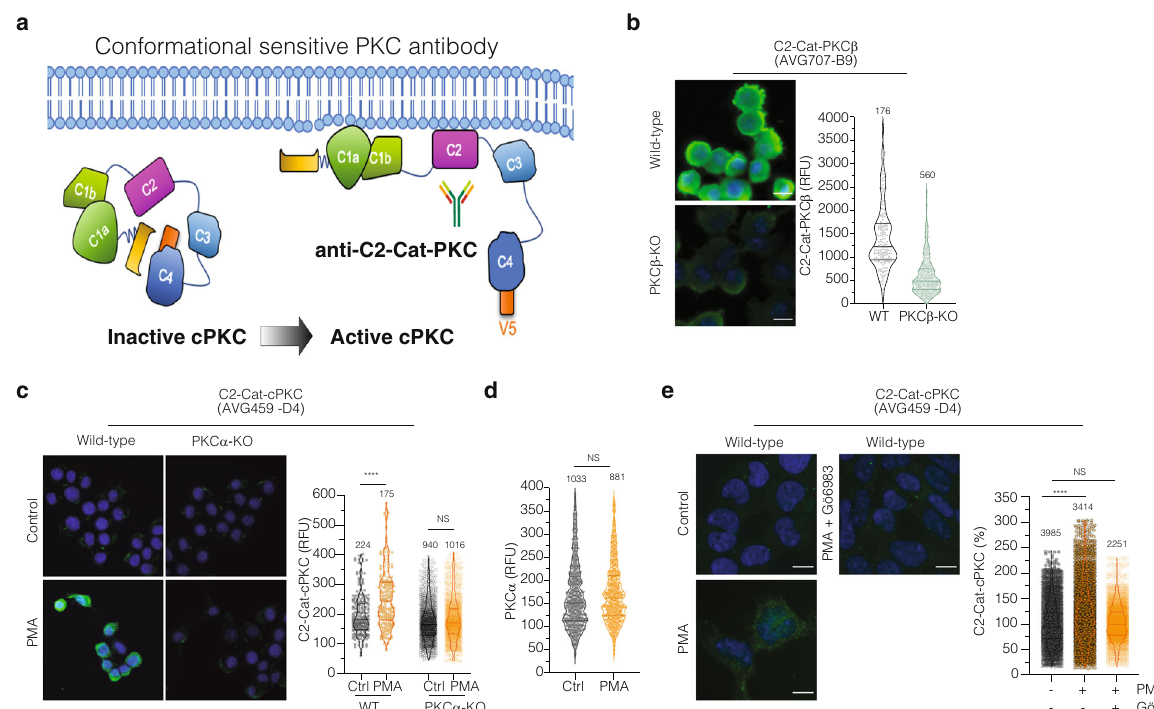
Fig. 4 Validation of conformation-sensitive antibodies to classical PKCs. a Schematic of conformational changes involved in generation of the active state of cPKC. Purple represents the C2 domain that becomes exposed after cPKC activation. This domain is recognized by two C2-Cat-cPKC antibodies: the C2- Cat-PKC β antibody (speci fi c for PKC β ), and the C2-Cat-cPKC antibody (recognizes all the classical cPKC isoenzymes). b Neuro2A and Neuro2A PKC β -KO cells were probed with anti-C2-Cat-PKC β (AVG707-B9) antibody. Images were acquired using the InCell microscope (×40) and fl uorescence intensity measured by Cell Pro fi ler software. Representative images with the antibody staining in green and DAPI in blue are shown. Volcano plot, each dot represents one cell. Lines are mean ± SD of two experiments, number of counted cells are indicated. RFU indicates the integrated fl uorescence intensity units. **** p value < 0.0001; t -test. c Neuro2A and Neuro2A PKC α -KO cells were treated with PMA (100 nM) for 30 min and probed with anti-C2-Cat- cPKC antibody. Images were acquired and analyzed as previously described. **** p value < 0.0001; t -test. d Neuro2A cells were treated with PMA (100 nM) for 30 min and stained with anti-PKC α antibody (Santa Cruz; sc-8393). Images were acquired and analyzed as previously described. NS non-signi fi cant; p value > 0.99; t test. e SK-N-SH cells were treated with PMA (100 nM) with or without Gö6983 (1 μ M) for 30 min and stained with anti-C2-Cat-cPKC antibody. Images were acquired and analyzed as previously described. **** p value < 0.0001; t